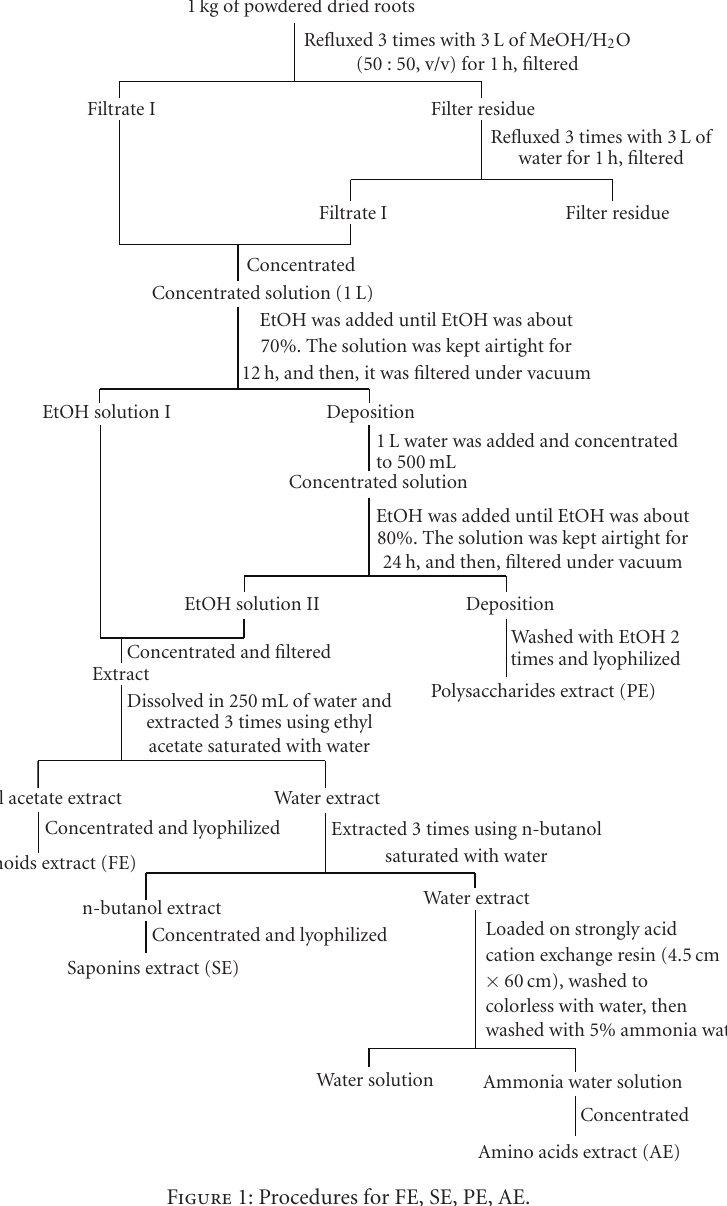
Figure 1: Procedures for FE, SE, PE,